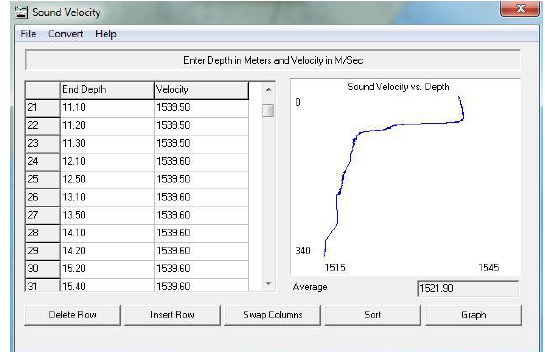
Figure 9: CTD profile measured for survey